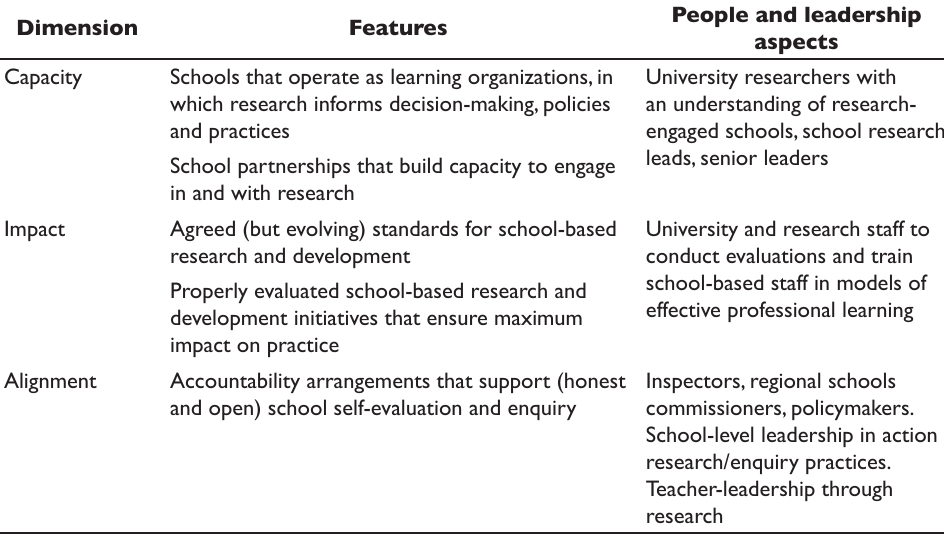
Table 1: Dimensions and features of an effective research and development ecosystem